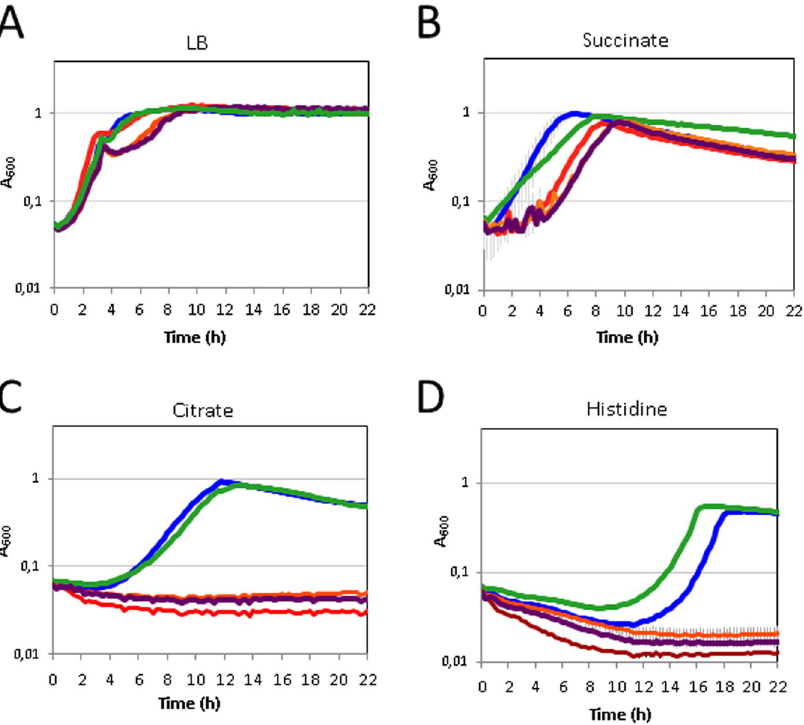
Figure 10. Growth of P. putida wild type, Δ cbrXA , Δ PAS, Δ TM and P tac Δ TM mutants in different carbon sources. Growth curves of the wild type strain (MPO451, blue), Δ cbrXA mutant (MPO495, red), Δ PAS (MPO507, orange), Δ TM (MPO508, purple) and overexpressed P tac Δ TM (MPO506, green) in LB ( A ) and in minimal medium with succinate ( B ), citrate ( C ) and histidine ( D ) as the sole carbon sources. One representative experiment of the three biological replicas is shown, and error bars represent the standard deviation of the three technical replicates for the biological replicate